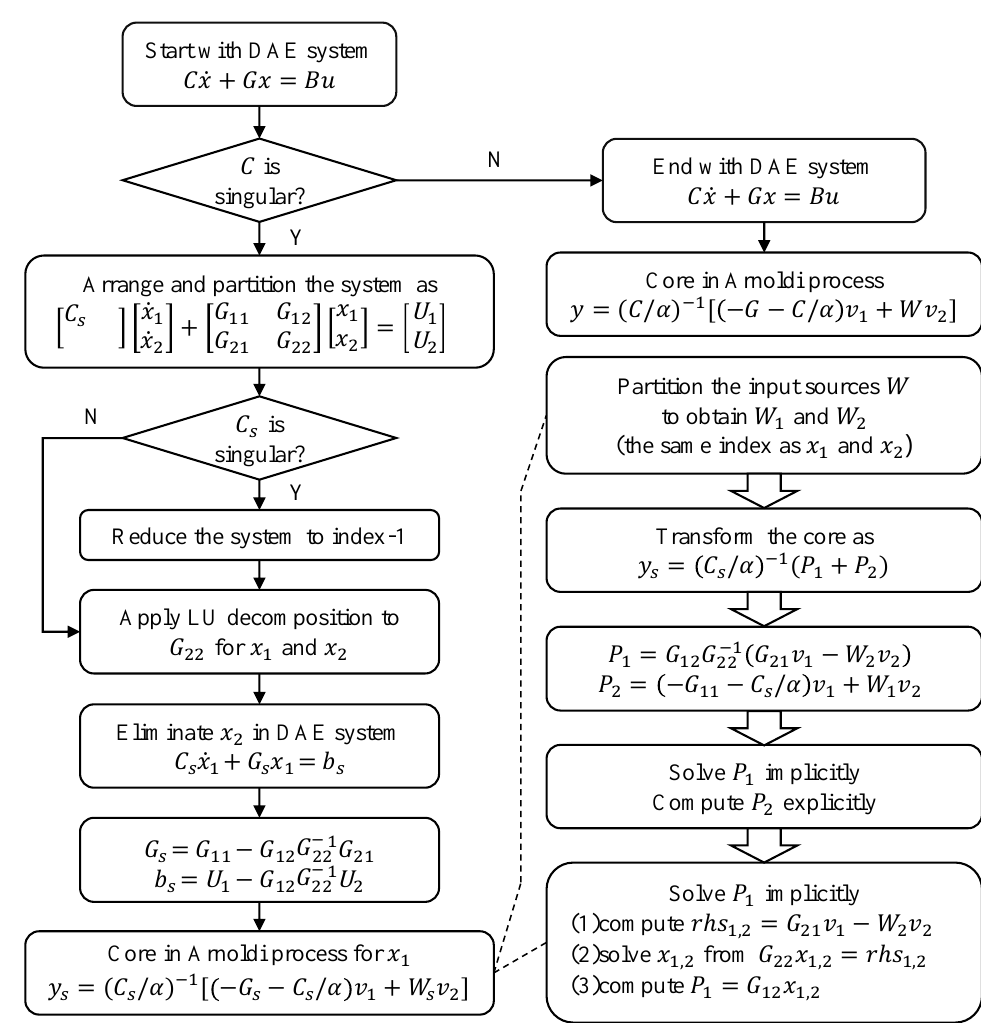
Figure 2. Flow of the proposed